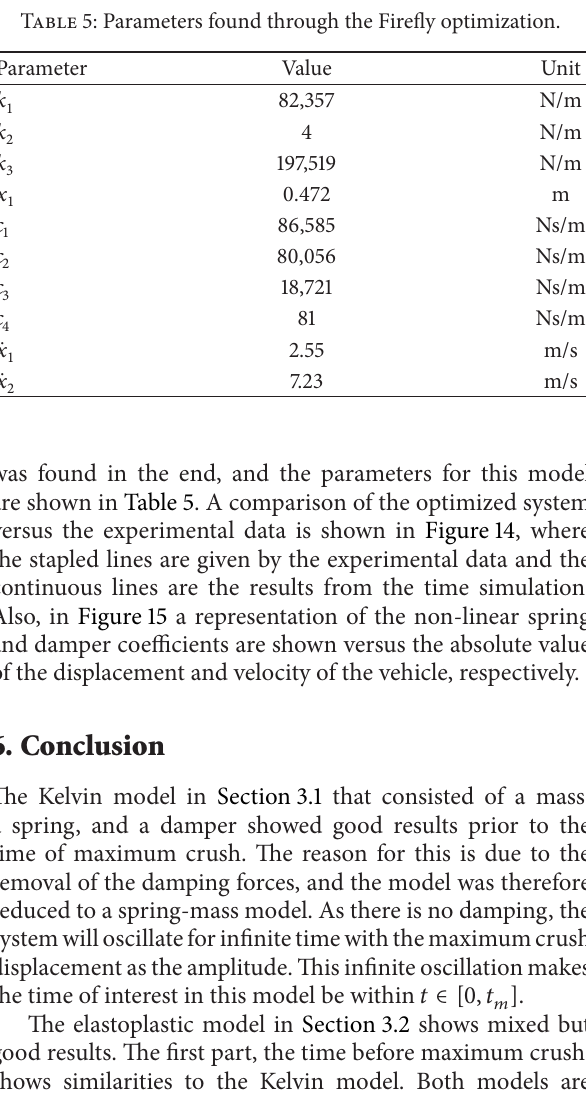
Figure 12: Results and comparison Maxwell model.